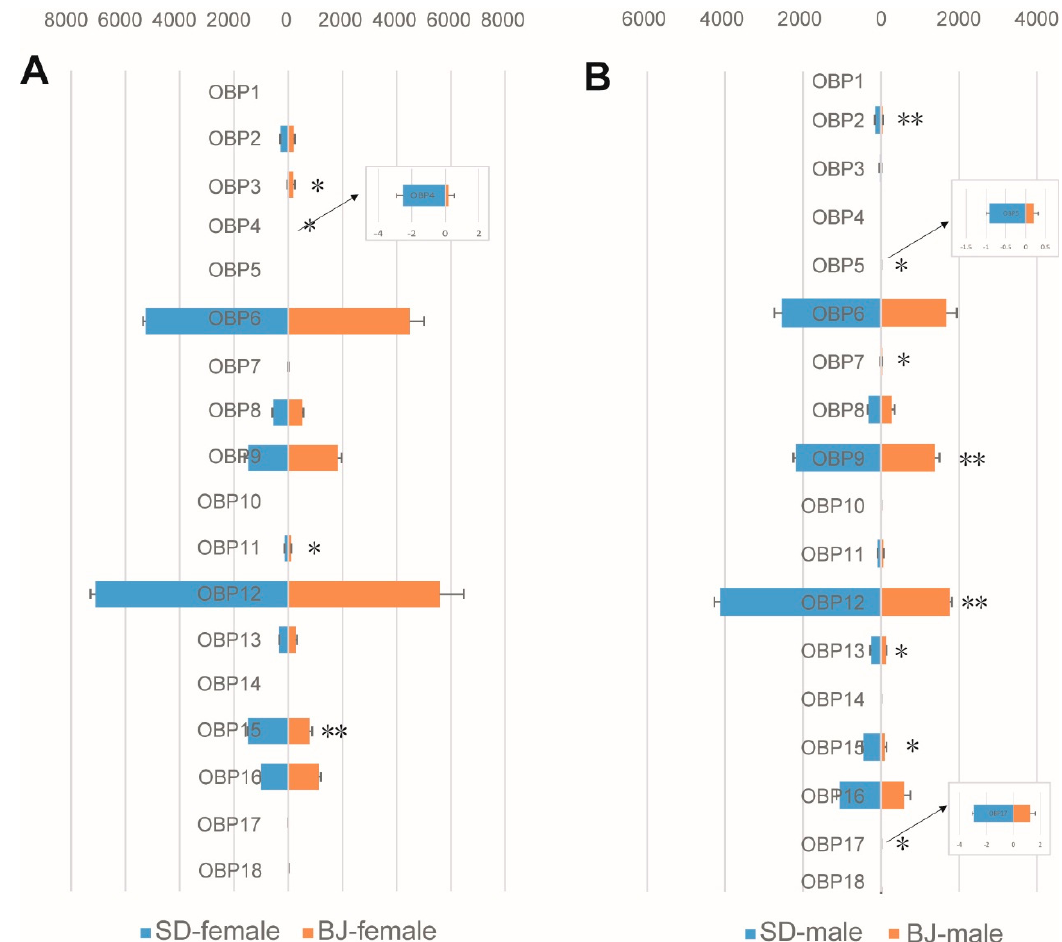
Figure 1. Comparison of odorant binding protein (OBP) genes expression levels in both sexes of the two S. bifasciatus populations. The horizontal axis refers to the expression level of the genes (FPKM values, mean ± SE, n = 3). ( A ): OBPs expression level comparison between females of the two population; ( B ): OBPs expression level comparison between males of the two population. BJ, Beijing population; SD, Shandong population. * means the difference is significant at the 0.05 level; ** means the difference is significant at the 0.01 level.